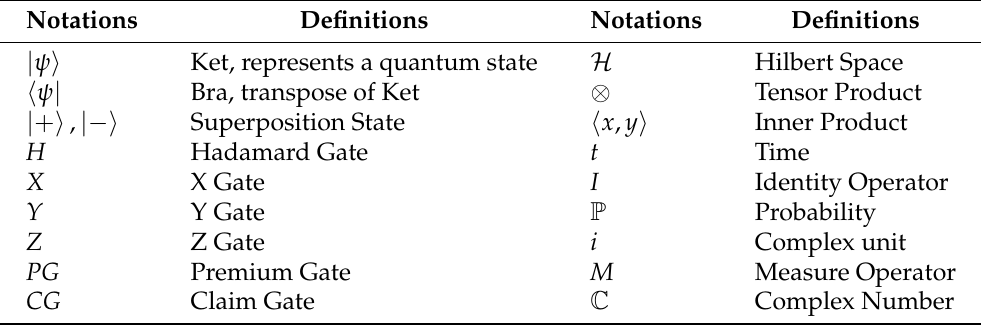
Table 2. Fundamental